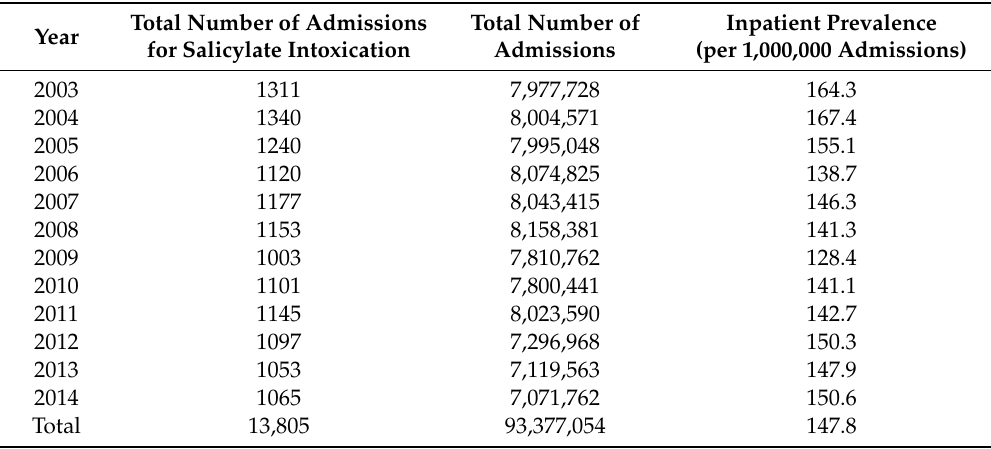
Table 2. Distribution and inpatient prevalence of salicylate intoxication from 2003 to